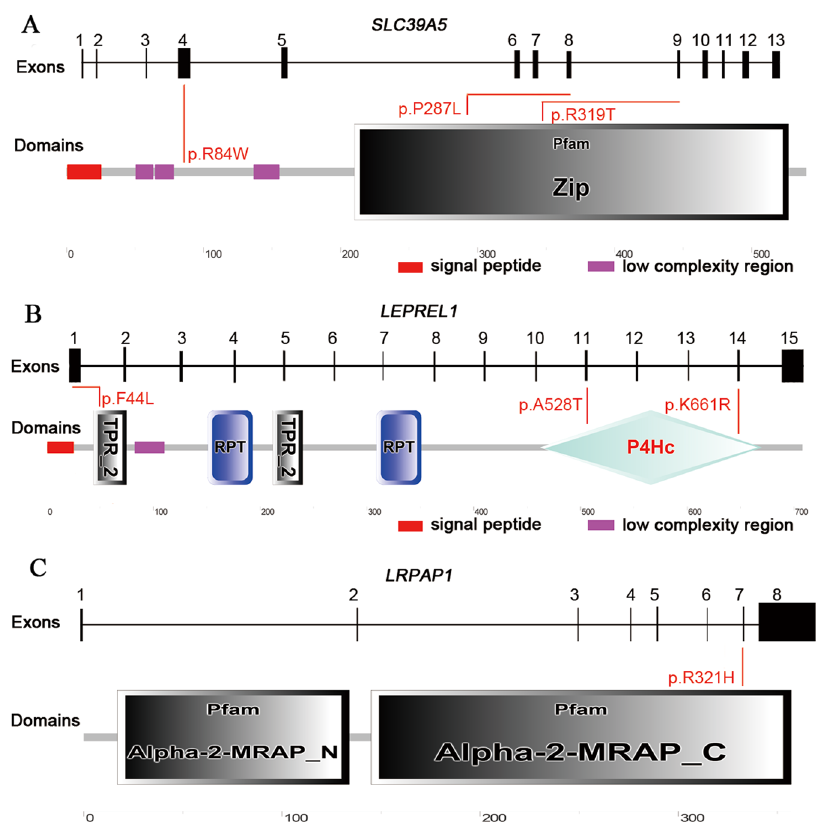
Figure 1. Location of the identifiedmutations in SLC39A5 , LEPREL1 and LRPAP1 . Exons of human SLC39A5 , LEPREL1 and LRPAP1 (upper), and positions of mutated residues corresponding to the topological model of the polypeptides (under). A total of seven missense mutations colored red were identified in this study. All mutations were located in the functional domains, except for the heterozygous mutation c.250C > T (p.Arg84Trp) in SLC39A5 (A,B,C). Pfam ZIP domain is responsible for metal ion transmembrane transporter activity ( A ). Proteins containing TPRs are involved in many biological processes, such as cell cycle regulation, mitochondrial and peroxisomal protein transport, neurogenesis and protein folding, RPT is an internal repeat, P4Hc domain participatesin inoxidoreductase activity ( B ). Alpha-2-MRAP isa Pfam domain that binds to the alpha-2-macroglobulin receptor ( C